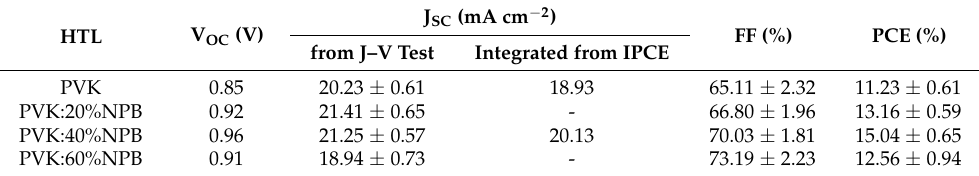
Figure 2. ( a ) J–V curves of PSCs; ( b ) external quantum efficiency and integrated J SC of PSCs; ( c ) the reverse and forward scanned J–V curves of control device and device based on PVK: 40% NPB HTL; ( d ) PCE statistics of PSCs; ( e ) normalized PCE values during storage in glovebox filled with N 2 ; and ( f ) stability of PSCs under continuous illustration by 1 sun (100 mW cm − 2 AM 1.5 G). Table 1. Summary of detailed performance parameters of PSCs.